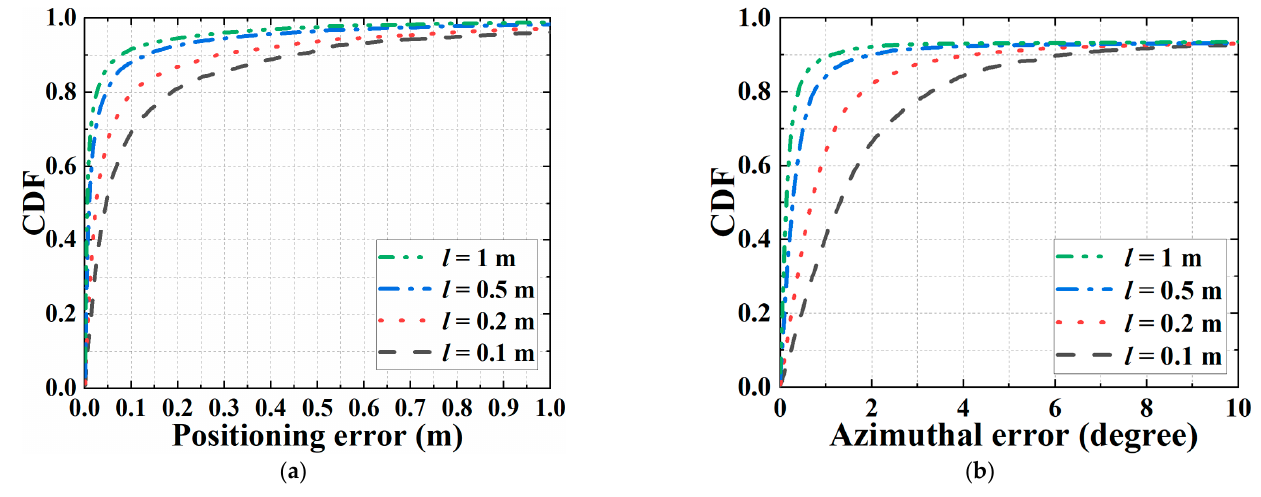
Figure 6. CDFs at the height of 1 m for: ( a ) 3D positioning errors; and ( b ) azimuthal errors. ( θ = 0°).